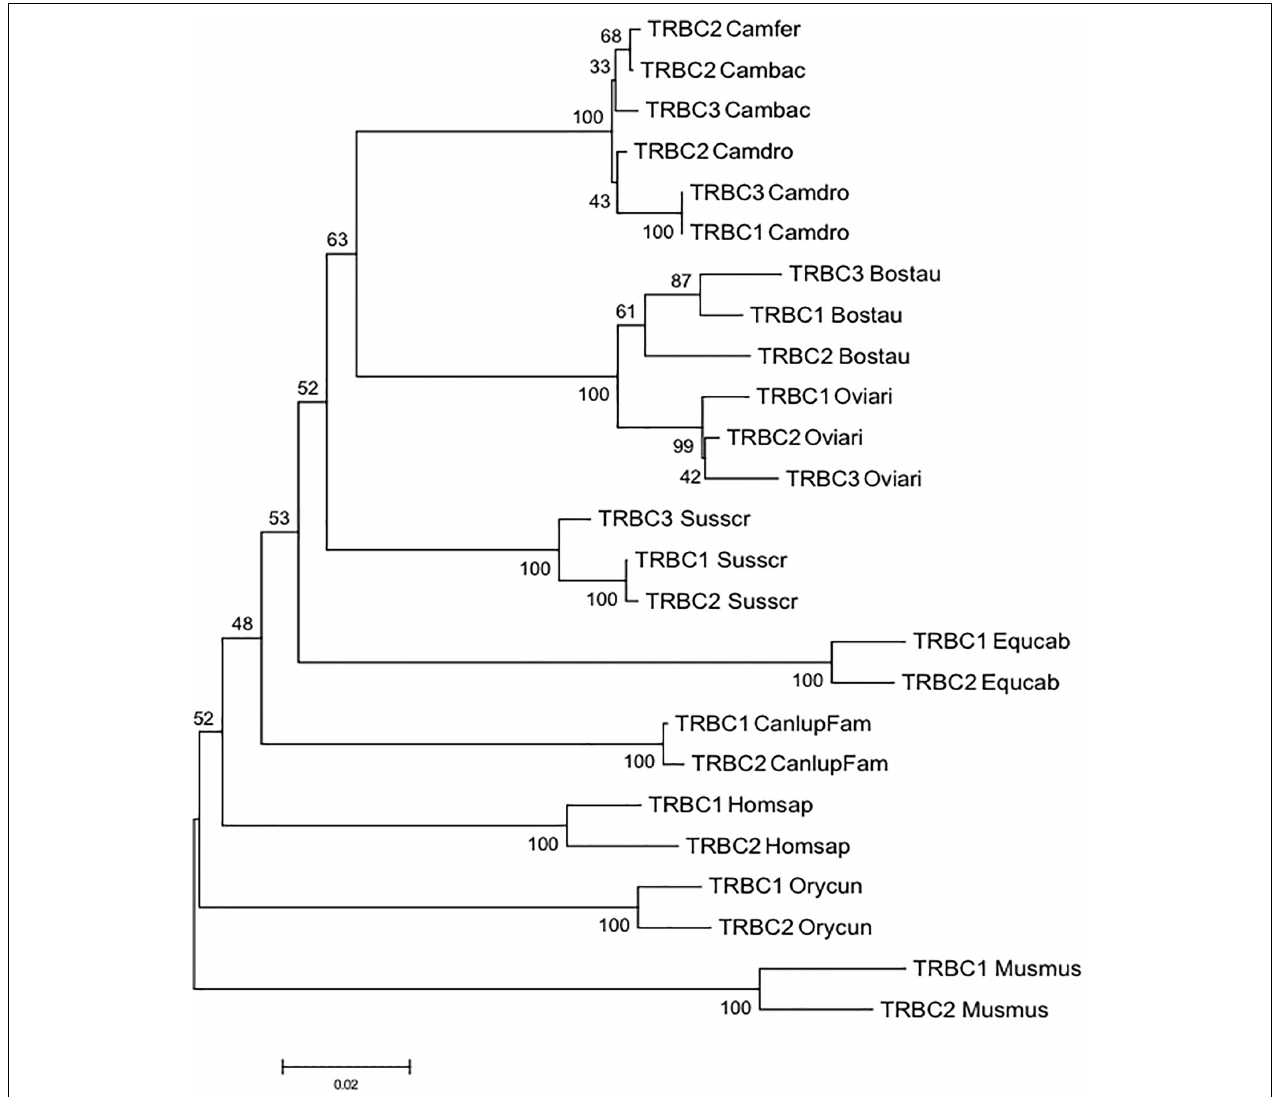
FIGURE 3 | The NJ tree inferred from the TRBC gene sequences within mammalian species. The evolutionary analysis was conducted in MEGA7 (Kumar et al., 2016). The percentage of replicate trees in which the associated taxa clustered together in the bootstrap test (100 replicates) is shown next to the branches (Felsenstein, 1985). The tree is drawn to scale with branch lengths in the same units as those of the evolutionary distances used to infer phylogenetic trees. The evolutionary distances were computed using the p-distance method (Nei and Kumar, 2000) and are in the units of the number of base differences per site. The analysis involved 25 nucleotide sequences. Codon positions included were 1st+2nd+3rd+Noncoding. All positions containing gaps and missing data were eliminated. There were a total of 515 positions in the final dataset. The IMGT 6-letter for species (Homsap, Musmus, Susscr, Bostau, Oviari, Equcab, Orycun, Camdro, Camfer, and Cambac) and 9-letter for subspecies (Canlupfam) standardized abbreviation for taxon is